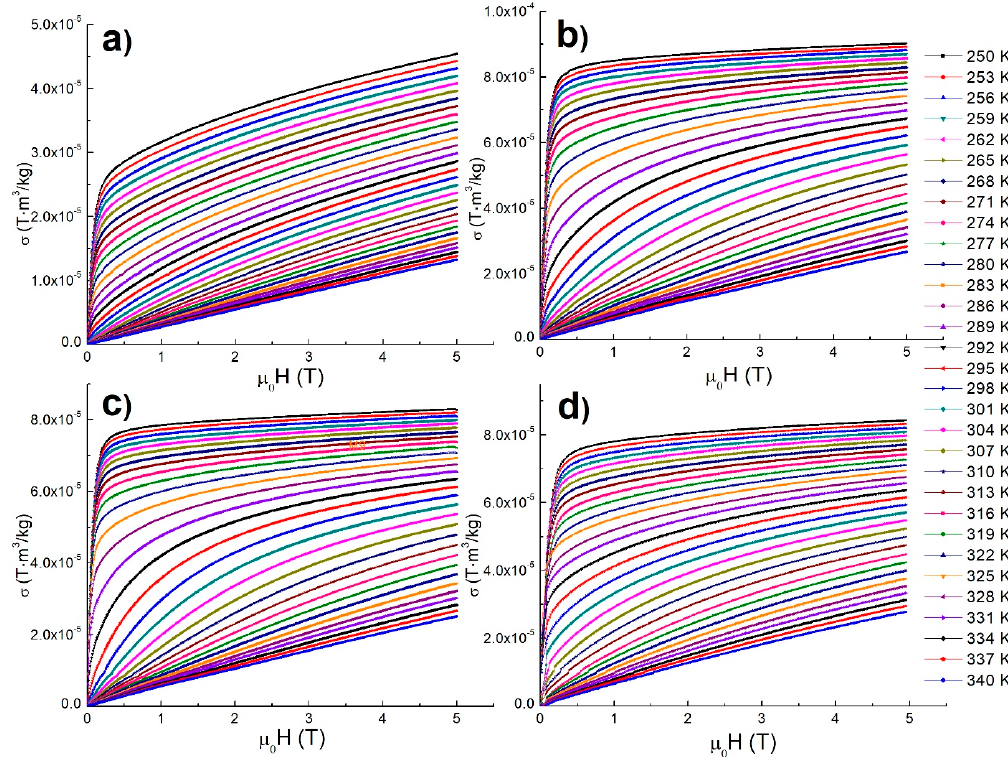
Figure 5. Magnetization versus applied magnetic field, measured at different temperatures, for manganites by ( a ) microwave-assisted sol-gel, ( b ) Pechini sol-gel, ( c ) solid-state reaction with planetary mill, and ( d ) solid-state reaction with attrition mill.